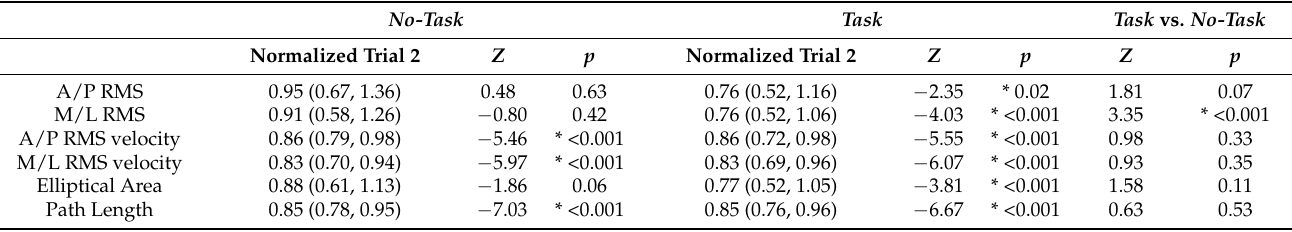
Table 3. Changes across post-drive trials described by normalized values for the post-drive trials and grouped by the Task condition for Exercise 3 (feet together/eyes closed/foam support). Median values (1st quartile and 3rd quartile) are shown. An asterisk (*) denotes a significant change in the second trial from the first